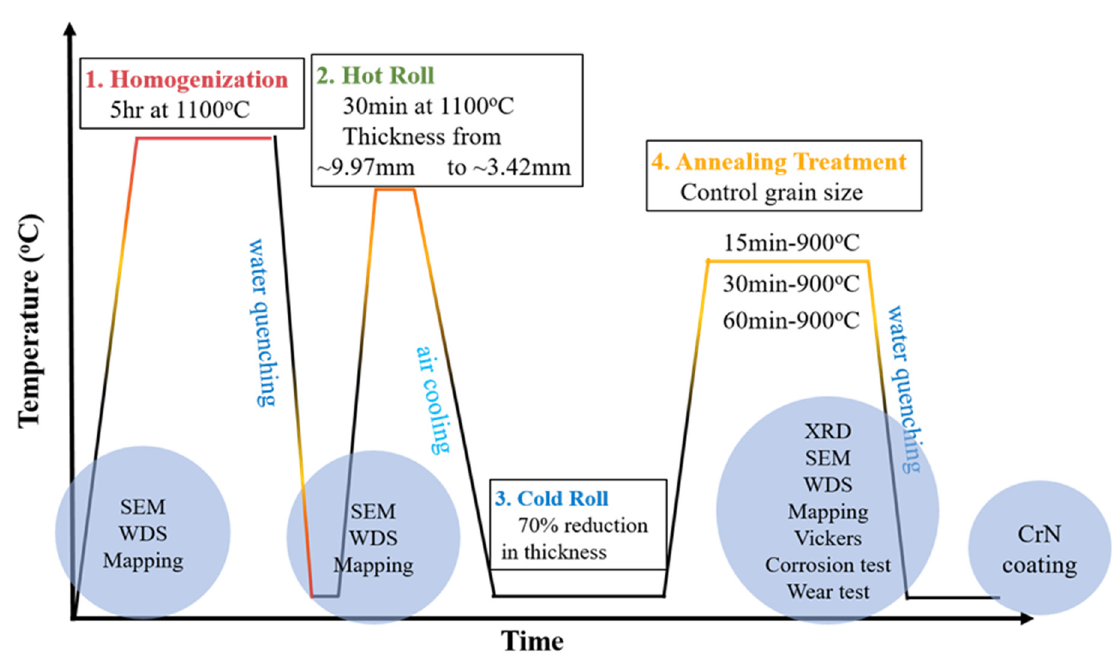
Figure 1. Experimental flow chart of this study.